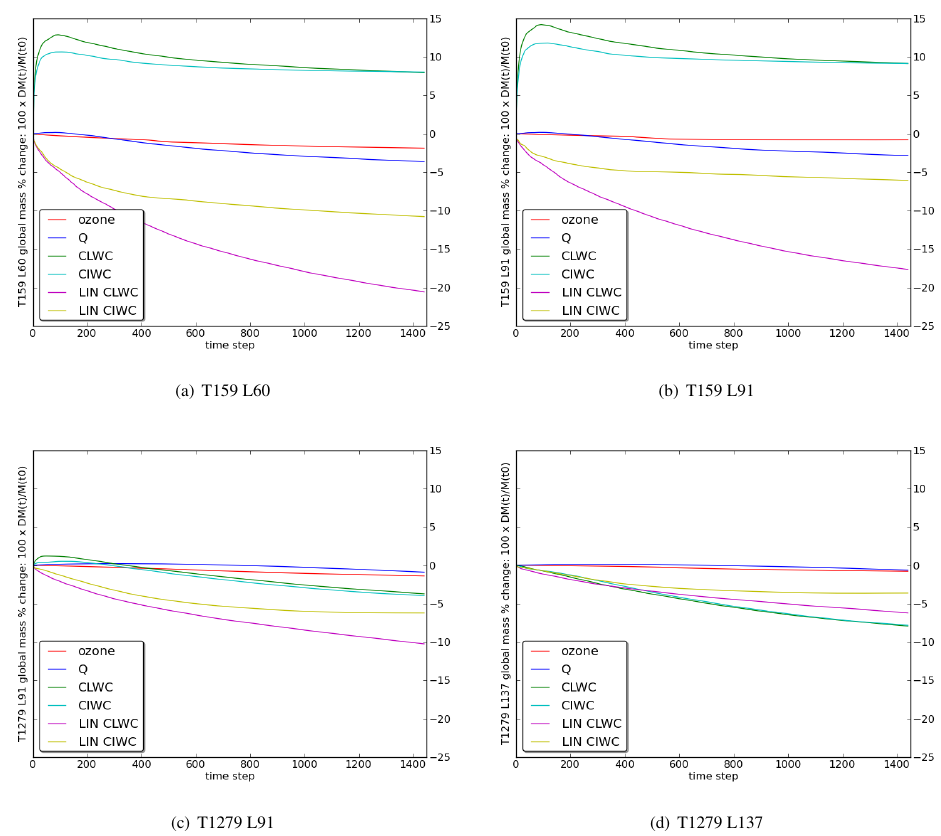
Fig. 1. Mass conservation error of the IFS SL advection scheme as a percent of initial global mass for ozone, Q, CLWC, CIWC at different horizontal and vertical resolutions using a quasi-monotonic bi-cubic or a linear (LIN, CLWC and CLIC only) interpolation scheme.